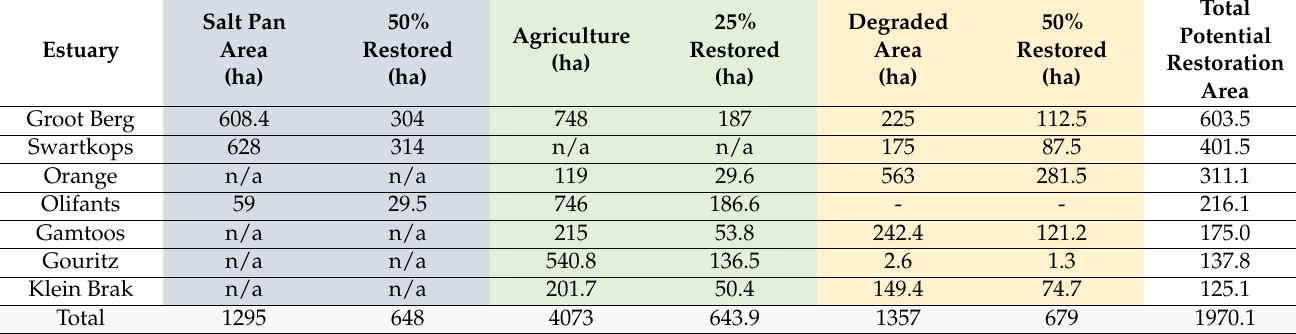
Table 3. Priority estuaries for salt marsh restoration. Area (ha) of salt marsh lost in specific estuaries due to the salt pan development, agriculture, and other (degraded) activities. The potential for restoration (gain in extent) assumes that it will be possible to restore 50% of the salt pan area, 25% of the agricultural area, and 50% of the degraded